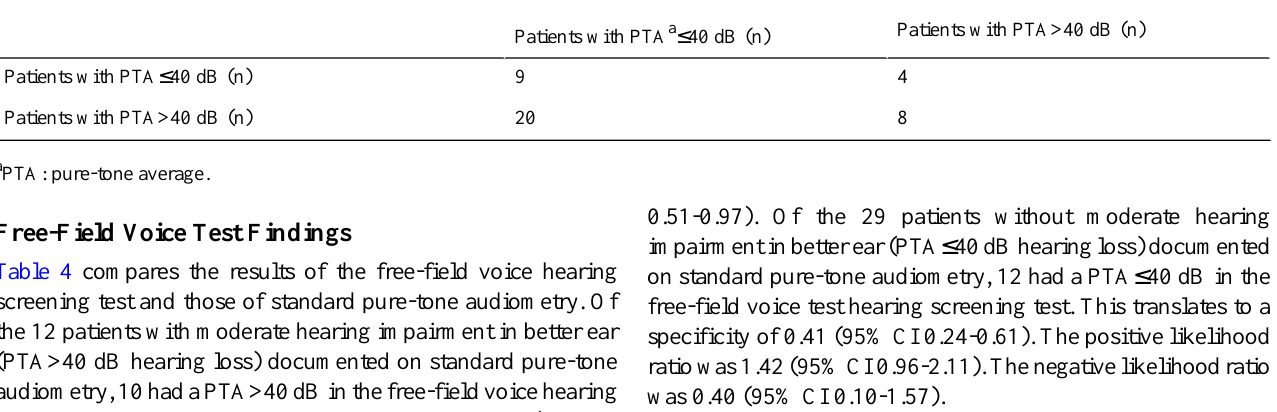
Standard pure-tone audiometryHHIE-S questionnaire